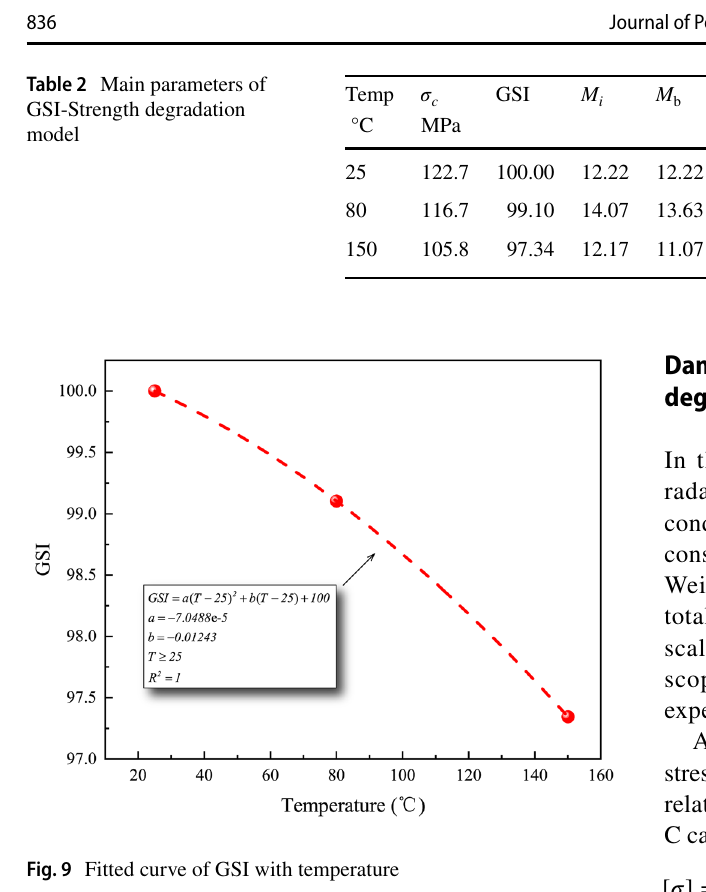
Fig. 9 Fitted curve of GSI with